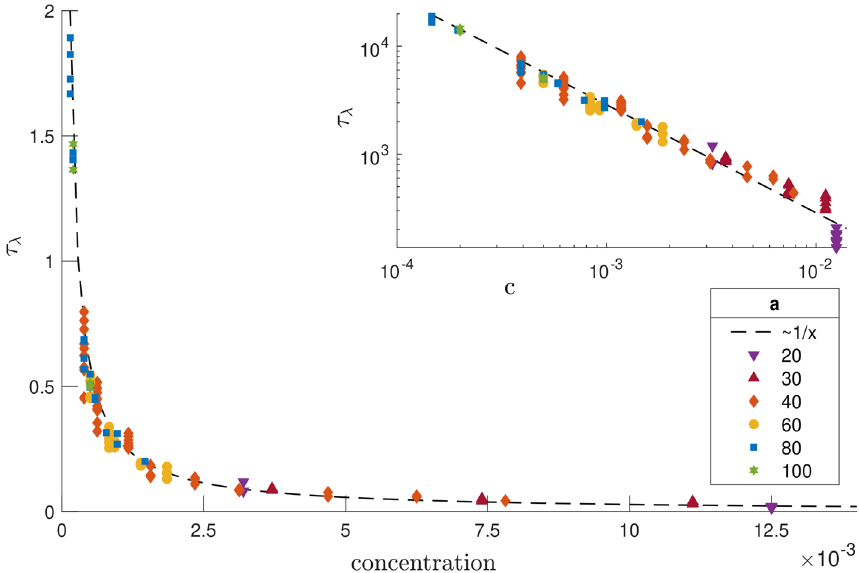
Figure 5. Characteristic time for the growth of the wavelength, τ (cid:31) , as a function of the concentration, c , in our simulations (both quantities are plotted in dimensionless units). The time scale τ (cid:31) is obtained using a least- square quadratic fit of the wavelength of the form (cid:31) ( t )/ a = (cid:31) 0 / a + ( t /τ (cid:31) ) scaling as τ (cid:31) ∝ 1 / c . Inset: same plot in log-log